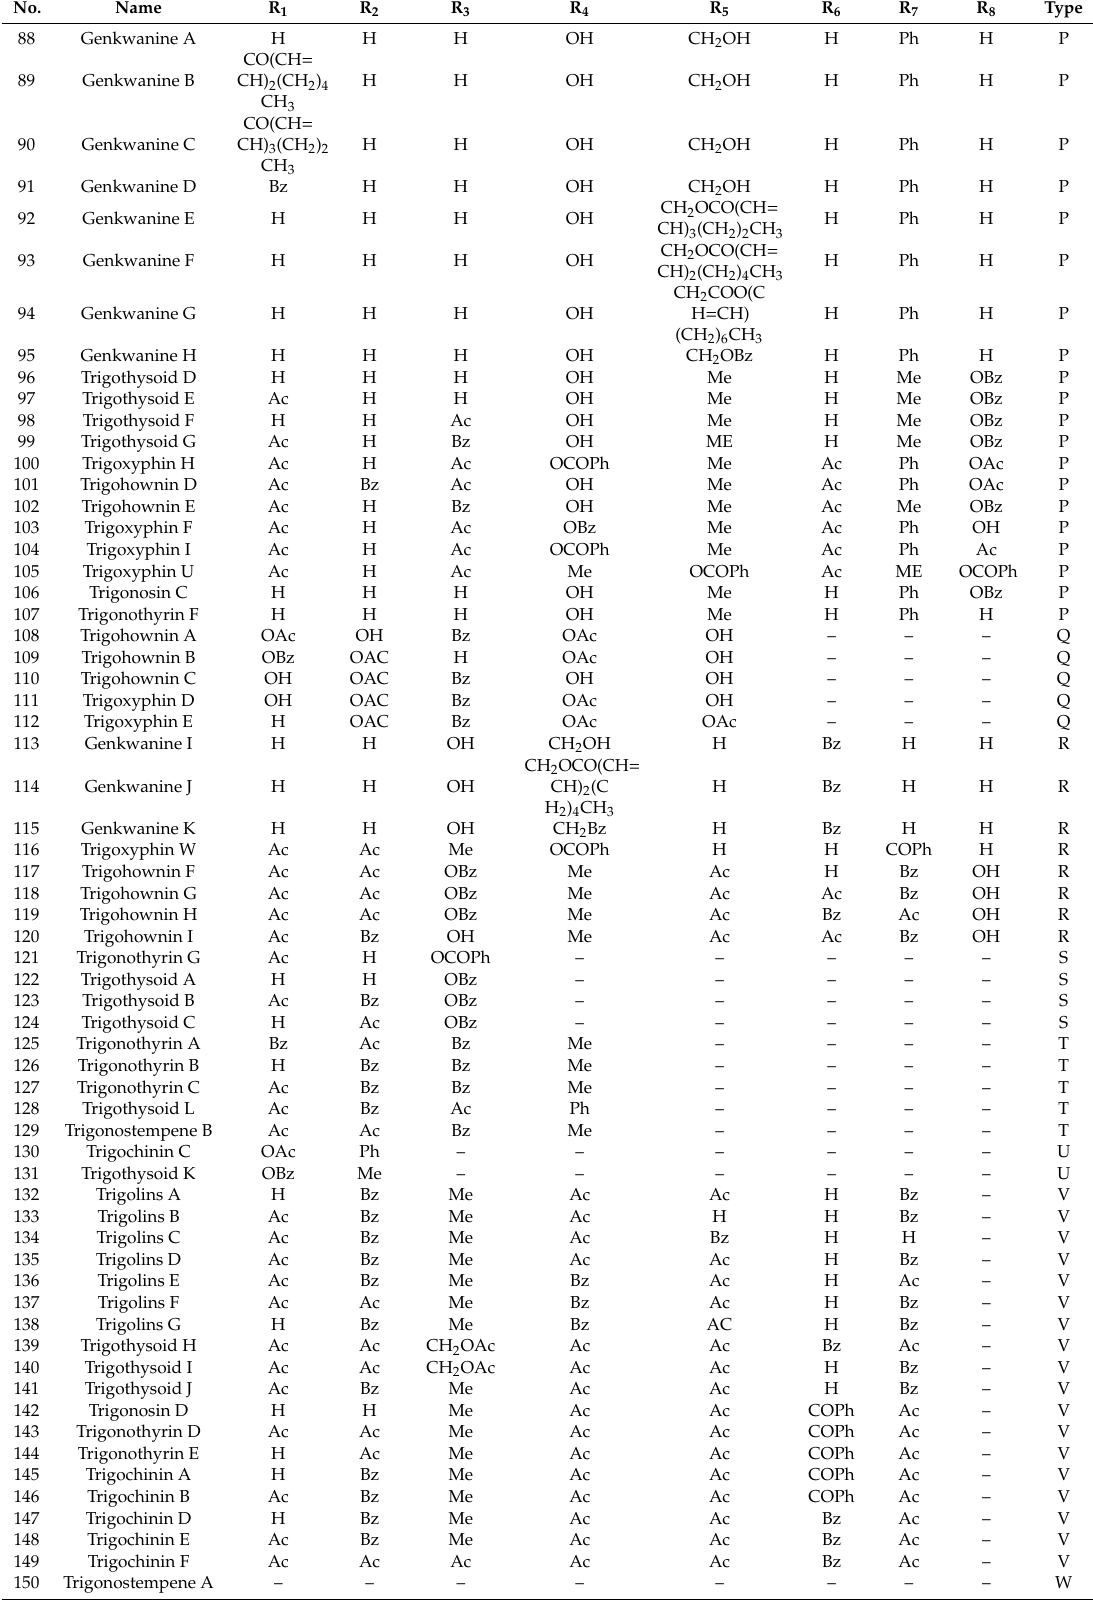
Table 4. Reported structures of genkwanines